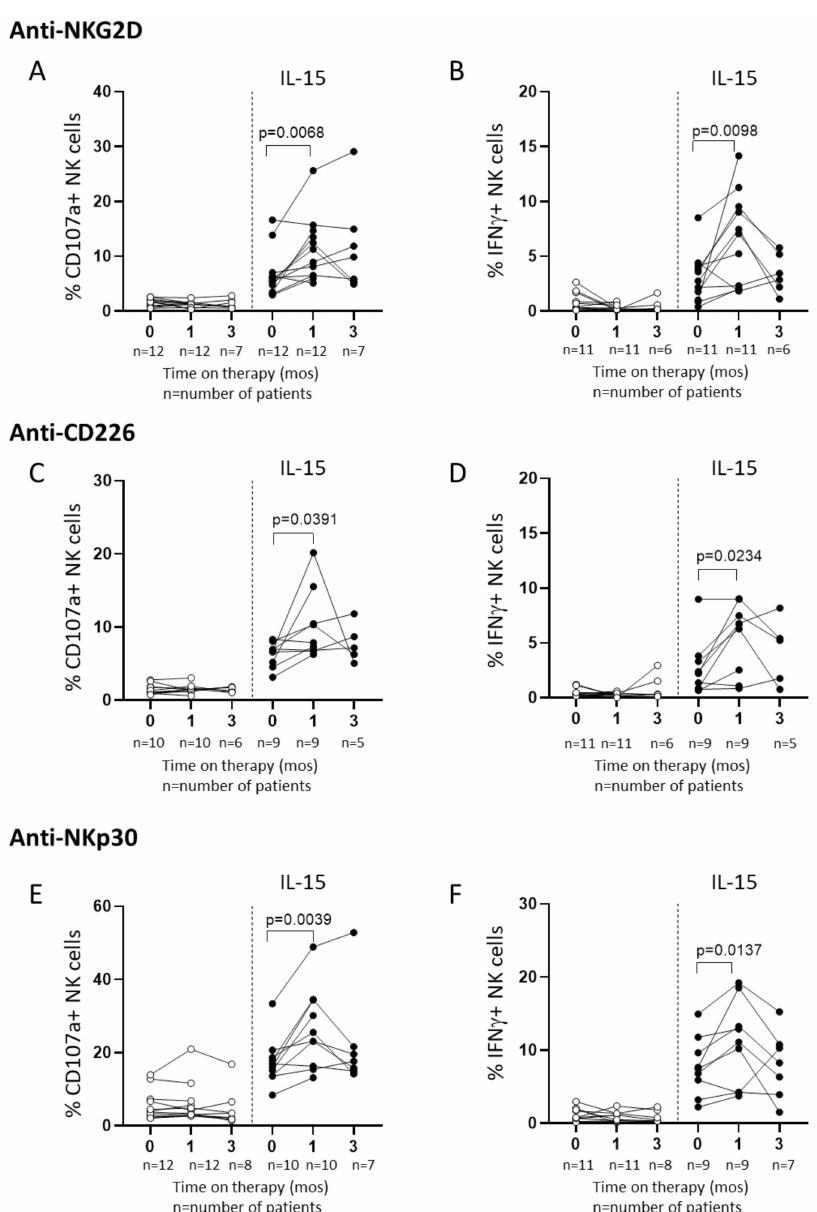
Figure 5. IL-15 stimulation restores the NK cell function in patients with HCC treated with sorafenib. NK cell degranulation and IFN γ production were evaluated before and after PBMC stimulation with IL-15 in rADCC assays by triggering NKG2D ( A , B ), CD226 ( C , D ), and NKp30 ( E , F ) receptors. The Wilcoxon matched-pairs signed rank test was used to analyze